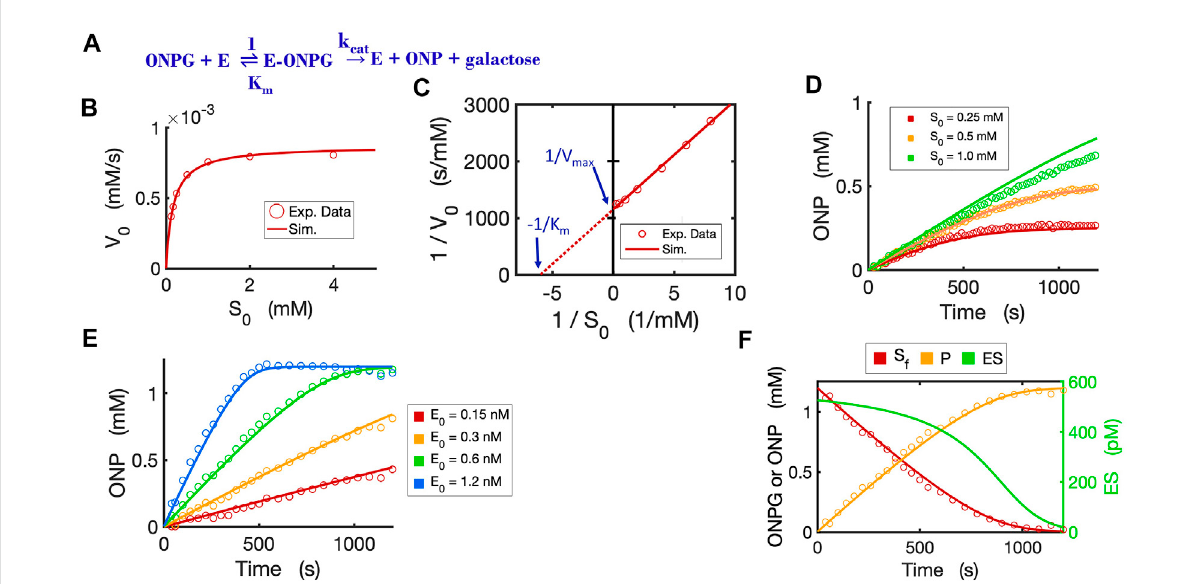
FIGURE 4 Circuit modeling of the kinetics of the beta-galactosidase reaction. (A) The enzymatic reaction scheme for E (beta-galactosidase) with its substrateONPG. (B) Circuitsimulationcurveofinitialreactionrate(V 0 )versusinitialsubstrateconcentration[S 0 ] fi ttedtotheexperimentaldata(when E 0 = 0.3 nM). (C) Lineweaver-Burk plot showing linearized curves of 1/V 0 ~1/S 0 with a Y -intercept of 1/V max and X -intercept of -1 /K m . (D) Circuit simulation curves of product dynamics over time with varying initial S concentrations fi tted to experimental data with E 0 = 0.3 nM. (E) Circuit simulation curves of product dynamics over time with varying initial enzyme concentrations (0.15 – 1.2 nM) fi tted to experimental data with S = 1.2 mM. (F) Model-predicted curves of the dynamics of [S f ], [ES] and [P] over time with E 0 = 0.6 nM and S 0 = 1.2 mM. The data points for [P] are experimental data while the data points for the free substrate [S f ] are calculated from stoichiometric conservation to be [S f ] = [S 0 ] - [P]. All simulation curvesareobtainedfromtheMichaelis-Menten circuitmodelwithexperimentallymeasuredK m =0.167 mMand k cat =2903/s.Notethattheresistor R=1/K m =1/0.000167=5988 Ω .Alldatapointsaremeansofthreeindependentreplicates.Thestandarddeviationsarerelativelysmall(lessthan20% of the corresponding mean) and are not